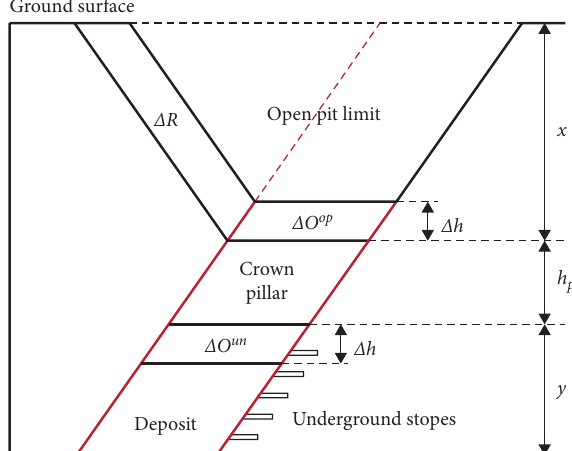
Figure 2: Schematic presentation for the optimization of surface- to-underground mining